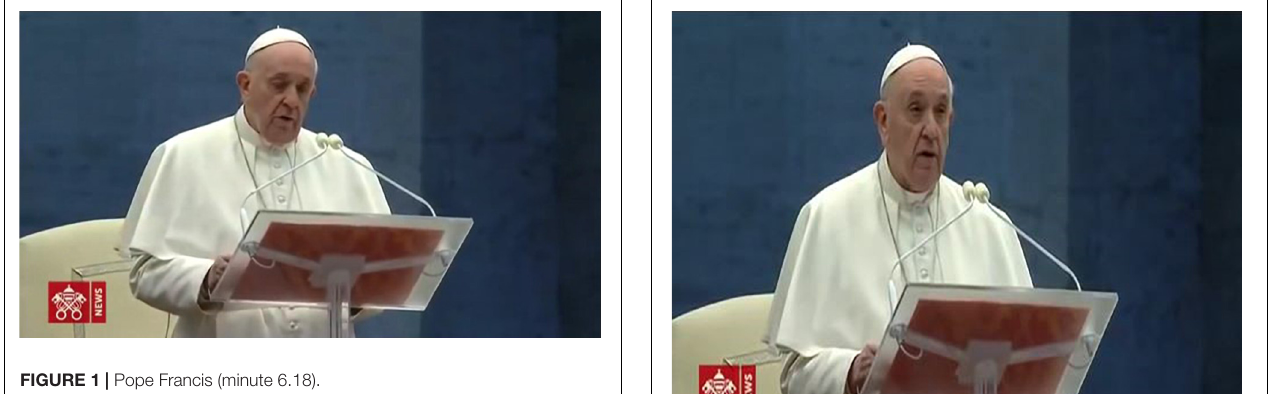
FIGURE 1 | Pope Francis (minute 6.18).